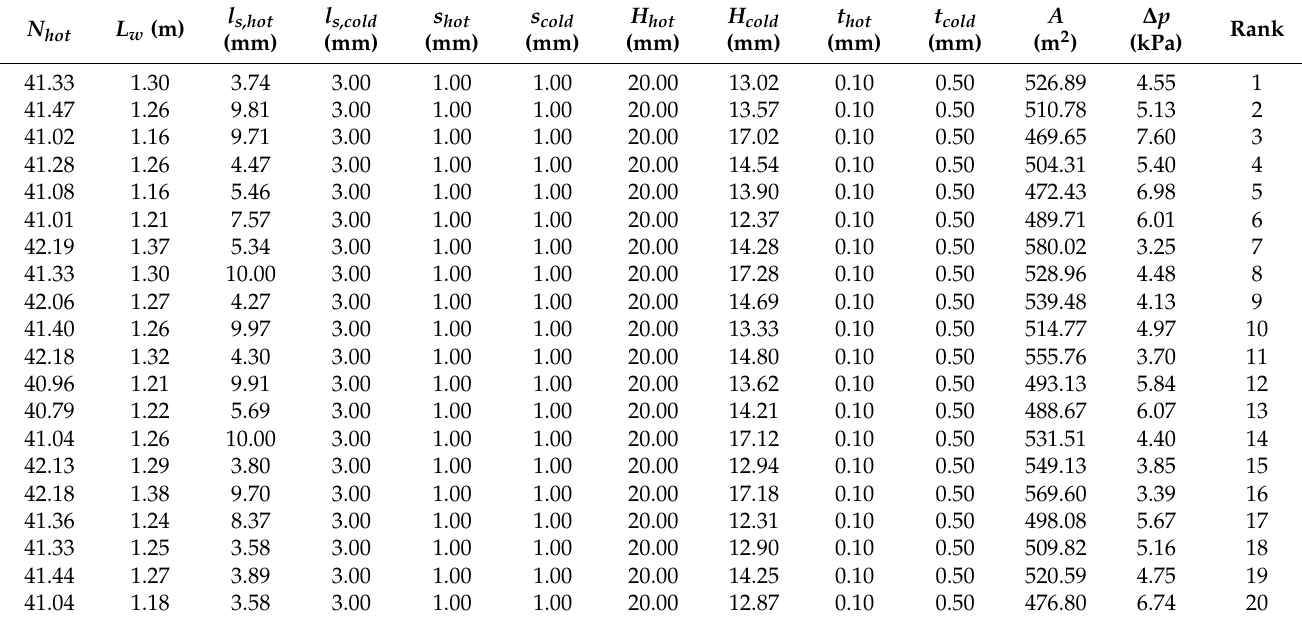
Table 4. Top 20 solutions with highest normalized